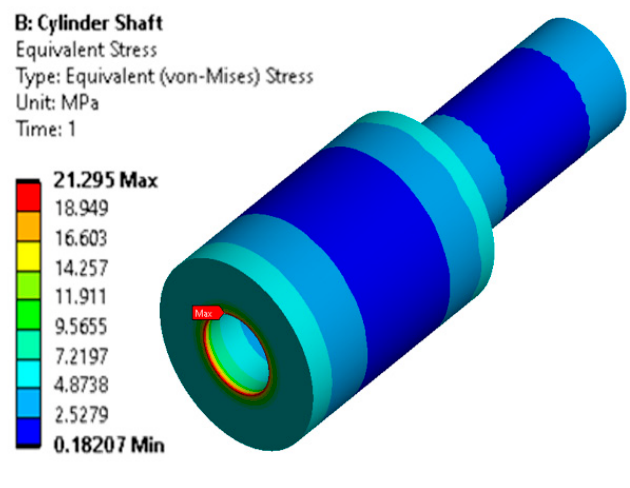
Figure 7. Analysis results for the housing base.